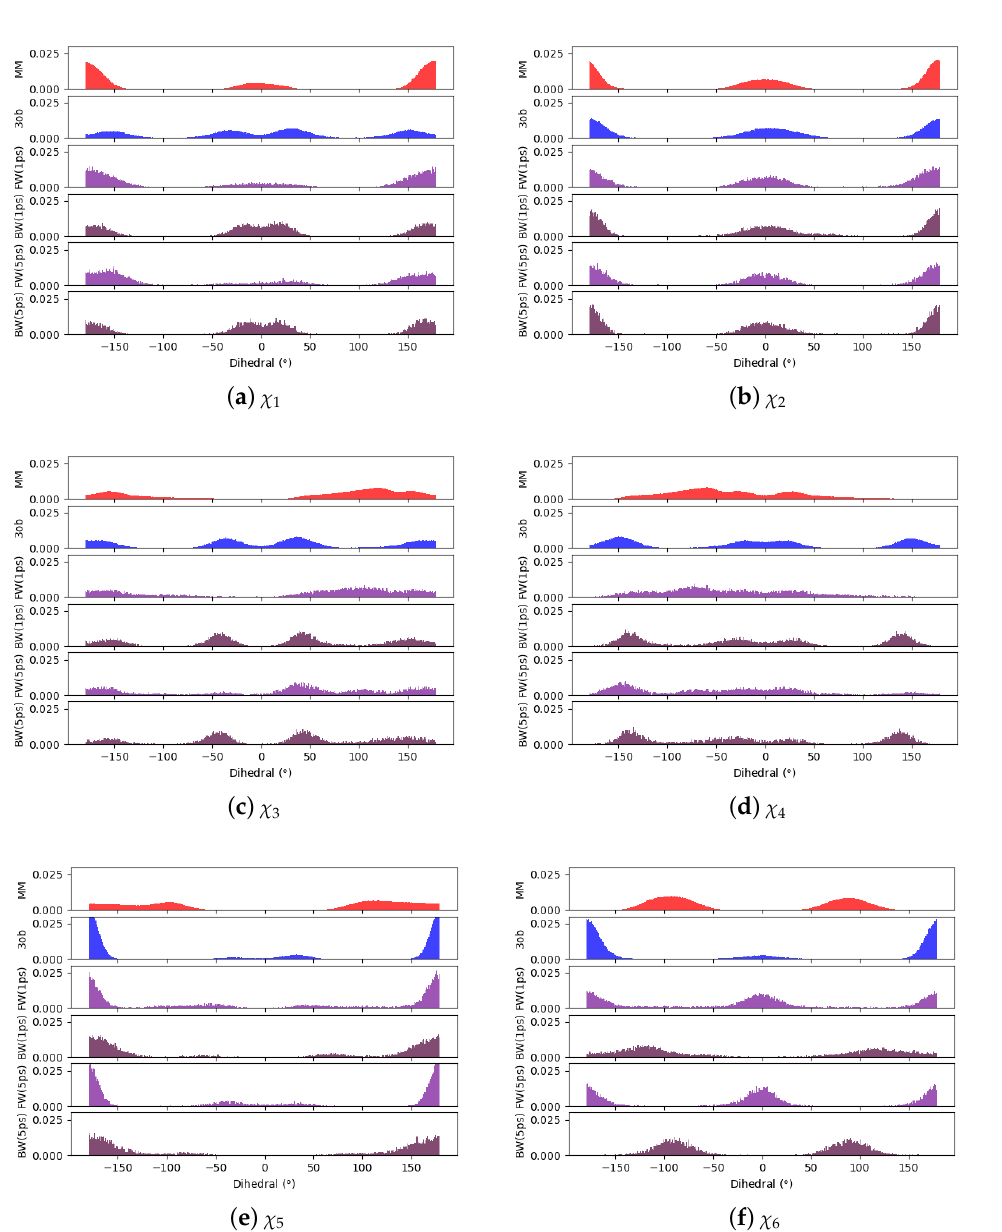
Figure 13. Dihedral populations for 9 ’s dihedral degrees of freedom (see Figure 2 for dihedral